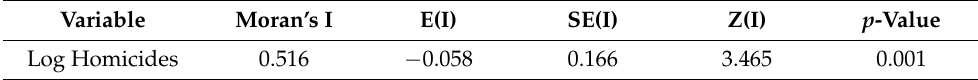
Table 8. Results of Moran’s